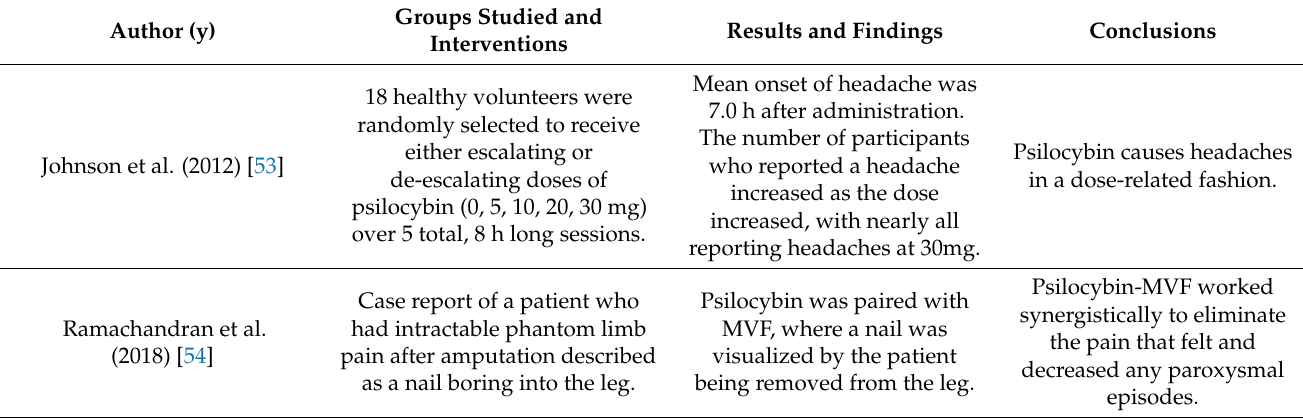
Table 3. Summary of studies regarding pain and